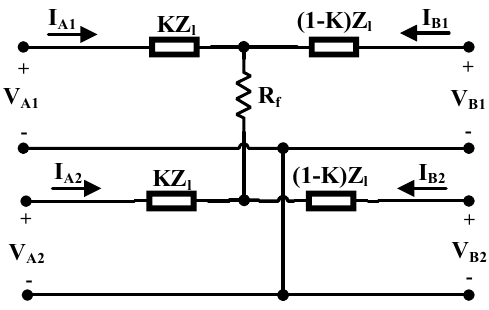
Figure 4. Sequence equivalent circuits for LL fault.